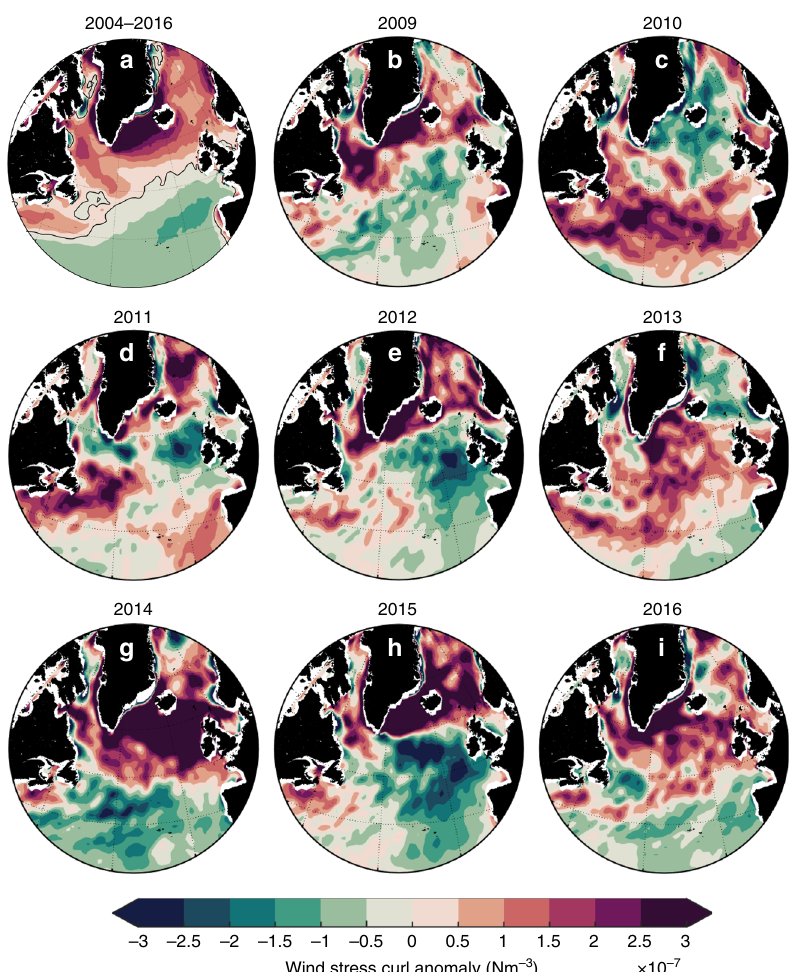
Fig. 9 Changes in winter wind stress curl. a 2005 – 2016 mean winter (DJFM) wind stress curl computed from the ERA-Interim reanalysis. b – i Annual anomalies of winter wind stress curl reference to the 2009 – 2016 mean. The same colour scale is used for all